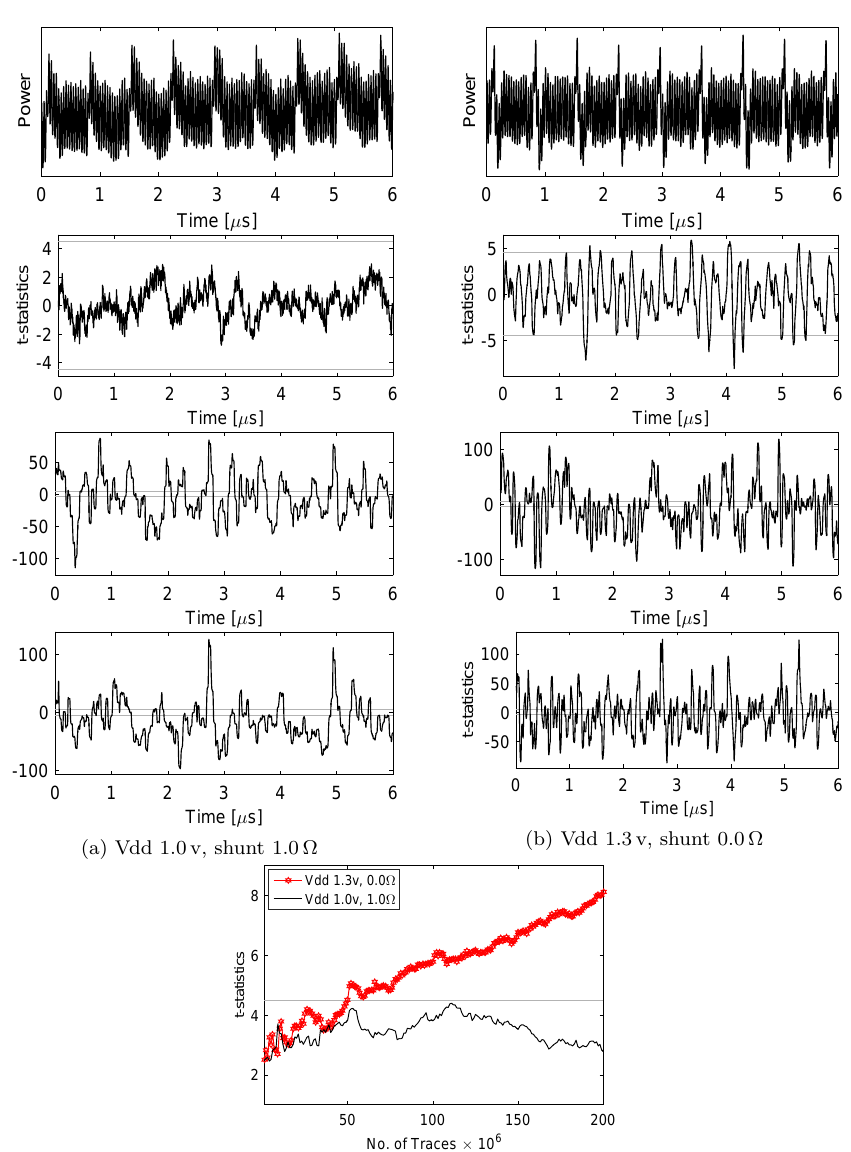
Figure 13: Case study 3: PRESENT TI, 3 shares, clock 12 MHz, room temperature, (top) average of 1000 power traces, (2nd row) 1st-order, (3rd row) 2nd-order and (4th row) 3rd-order t -test results using 200 million traces, (bottom) max ( | t | ) 1st-order over the number of